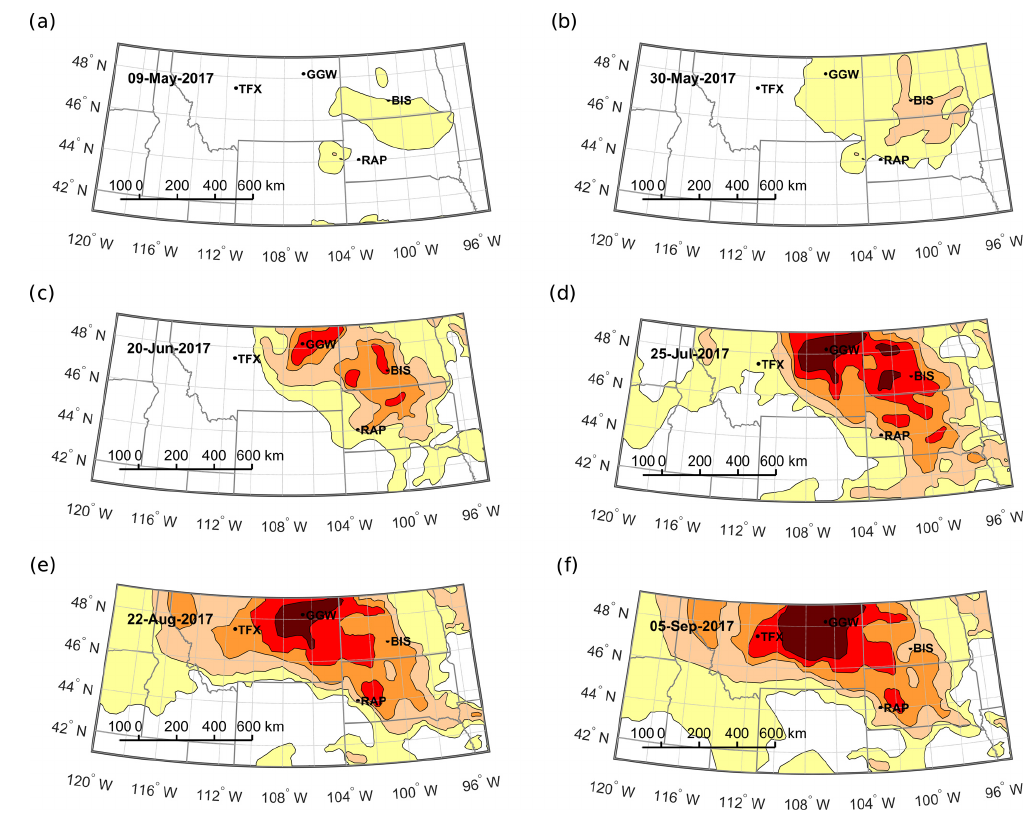
Figure 1. The US Drought Monitor classification of the 2017 Northern Great Plains flash drought during the weeks of (a) 9 May 2017, (b) 30 May 2017, (c) 20 June 2017, (d) 25 July 2017, (e) 22 August 2017, and (f) 5 September 2017. The locations of atmospheric sounding stations at Bismarck, Rapid City, Glasgow, and Great Falls are indicated. The dates were chosen according to drought development stages at the sites. D0 (abnormally dry) – yellow; D1 (moderate drought) – tan; D2 (severe drought) – orange; D3 (extreme drought) – red; D4 (exceptional drought) – dark